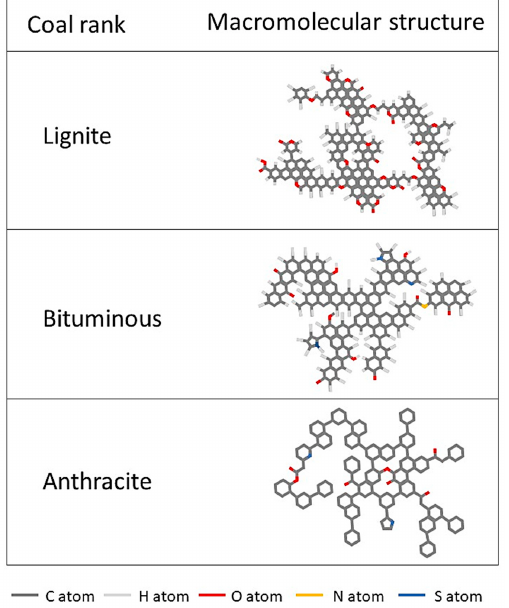
Figure 6. The macromolecular structure of a variety of coal ranks. Modified from [99].